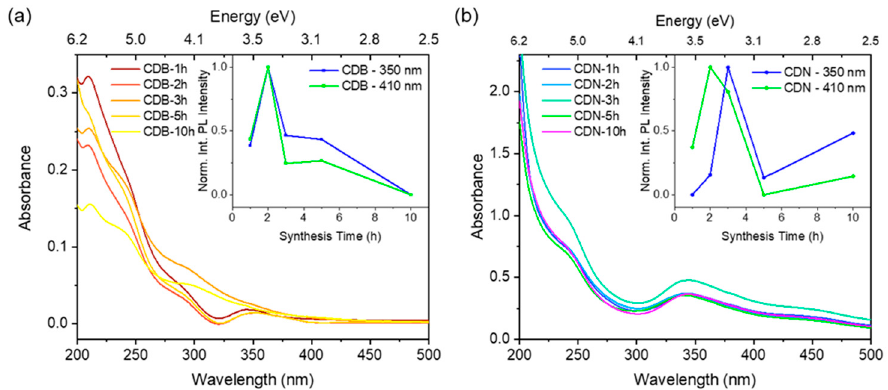
Figure 1. Optical absorption spectra of ( a ) CDB and ( b ) CDN samples obtained at different synthesis times. Insets: normalized integrated photoluminescence of CDB and CDN samples excited at 350 and 410 nm.